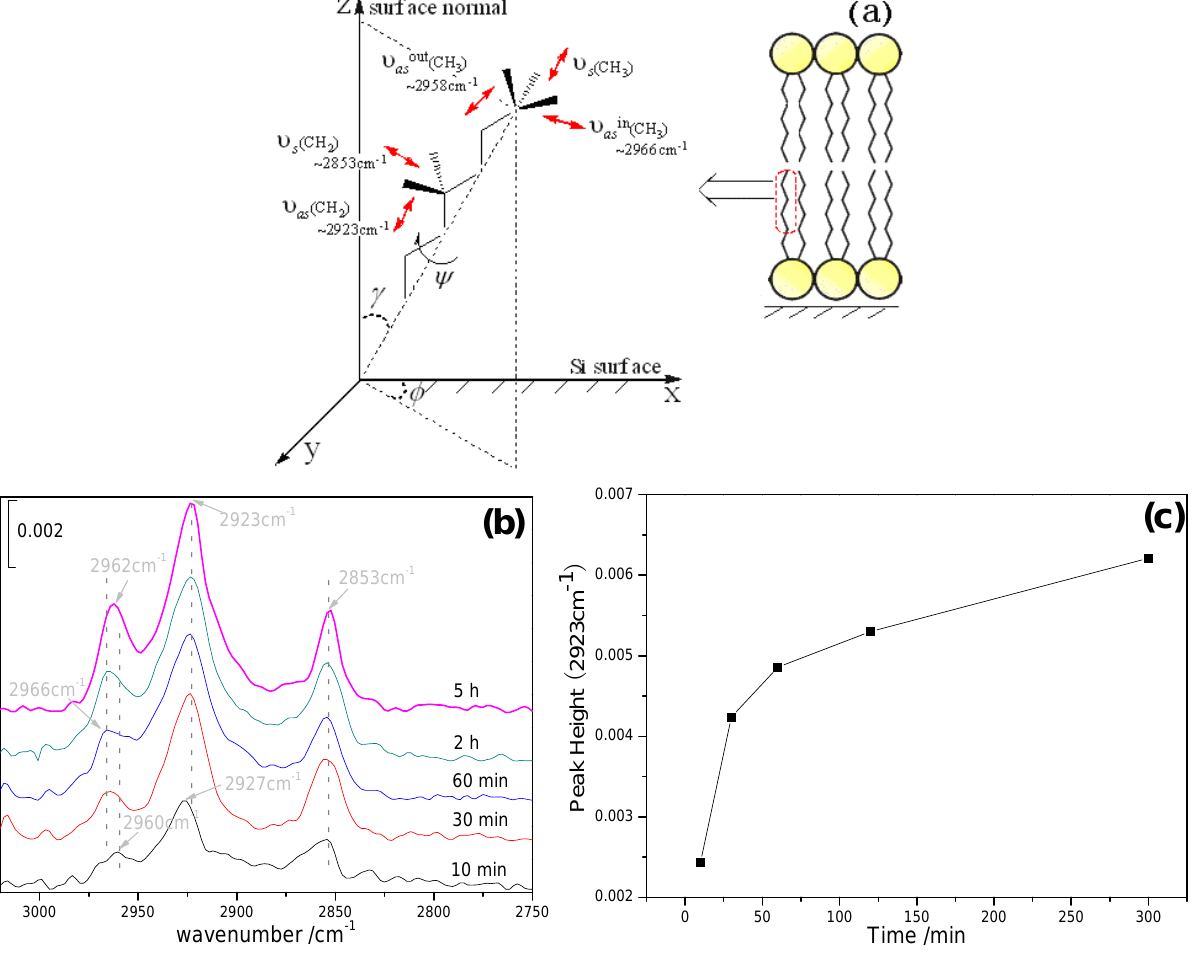
(b) P- polarized MTR-IR spectra in the C-H stretching region after 10, 30, 60 min, 2 and 5 h’s incubation respectively. (c) Self-assembly procedure presented with the peak height at 2923 cm -1 against the assembly